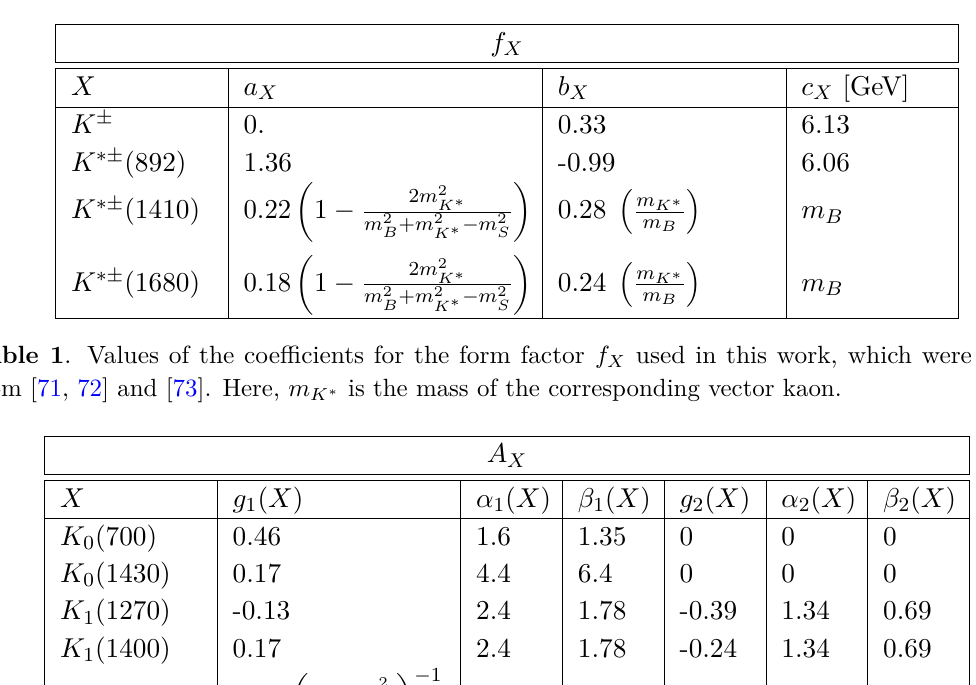
Figure 11 . Contributions to the h total decay width from h → SS (blue), h → Z D Z D (purple), h → SZ D Z D (red) and h → SSS (yellow) for g D = 10 − 1 (10 − 3 ) solid (dashed) lines as a function of m Z (left panel) and m S for m Z = 1 GeV (right panel). D D